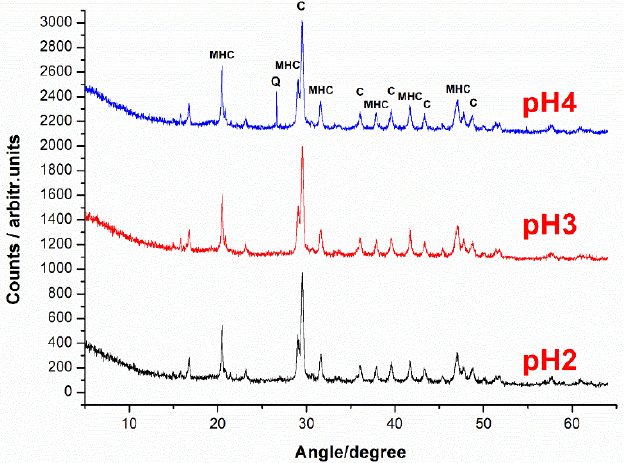
Figure 5. XRD pattern of the tablets exposed to acidic pH revealing the crystalline calcite signal (marked with C on the graph), as well as the monohydrocalcite signal (marked with MHC) and traces of quartz, probably from embedded environmental sand grain in native shell roughness.